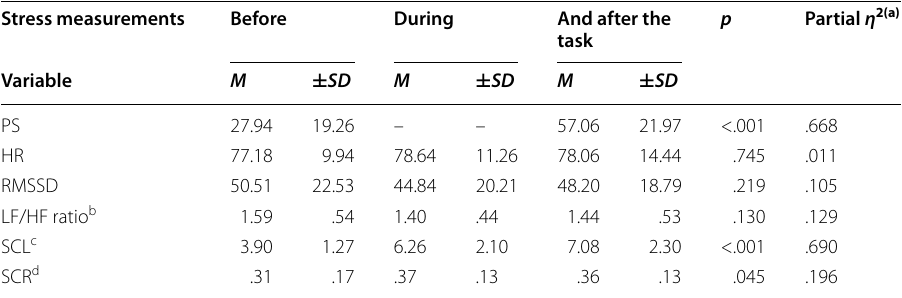
15 n (persons) 18; PS perceived stress [mm]; HR heart rate [bpm]; RMSSD ≤ ≤ = = differences [ms]; SCL skin conductance level [µS]; SCR mean amplitudes of skin conductance responses [µS] = = a Greenhouse‑Geisser‑adjusted p values; Multiple comparisons, Bonferroni‑corrected b LF/HF ( before ) > LF/HF ( during ), p .011 = c SCL ( before ) < SCL ( during ) < SCL ( after ), each p < .001 d SCR ( before ) < SCR ( after ), p =